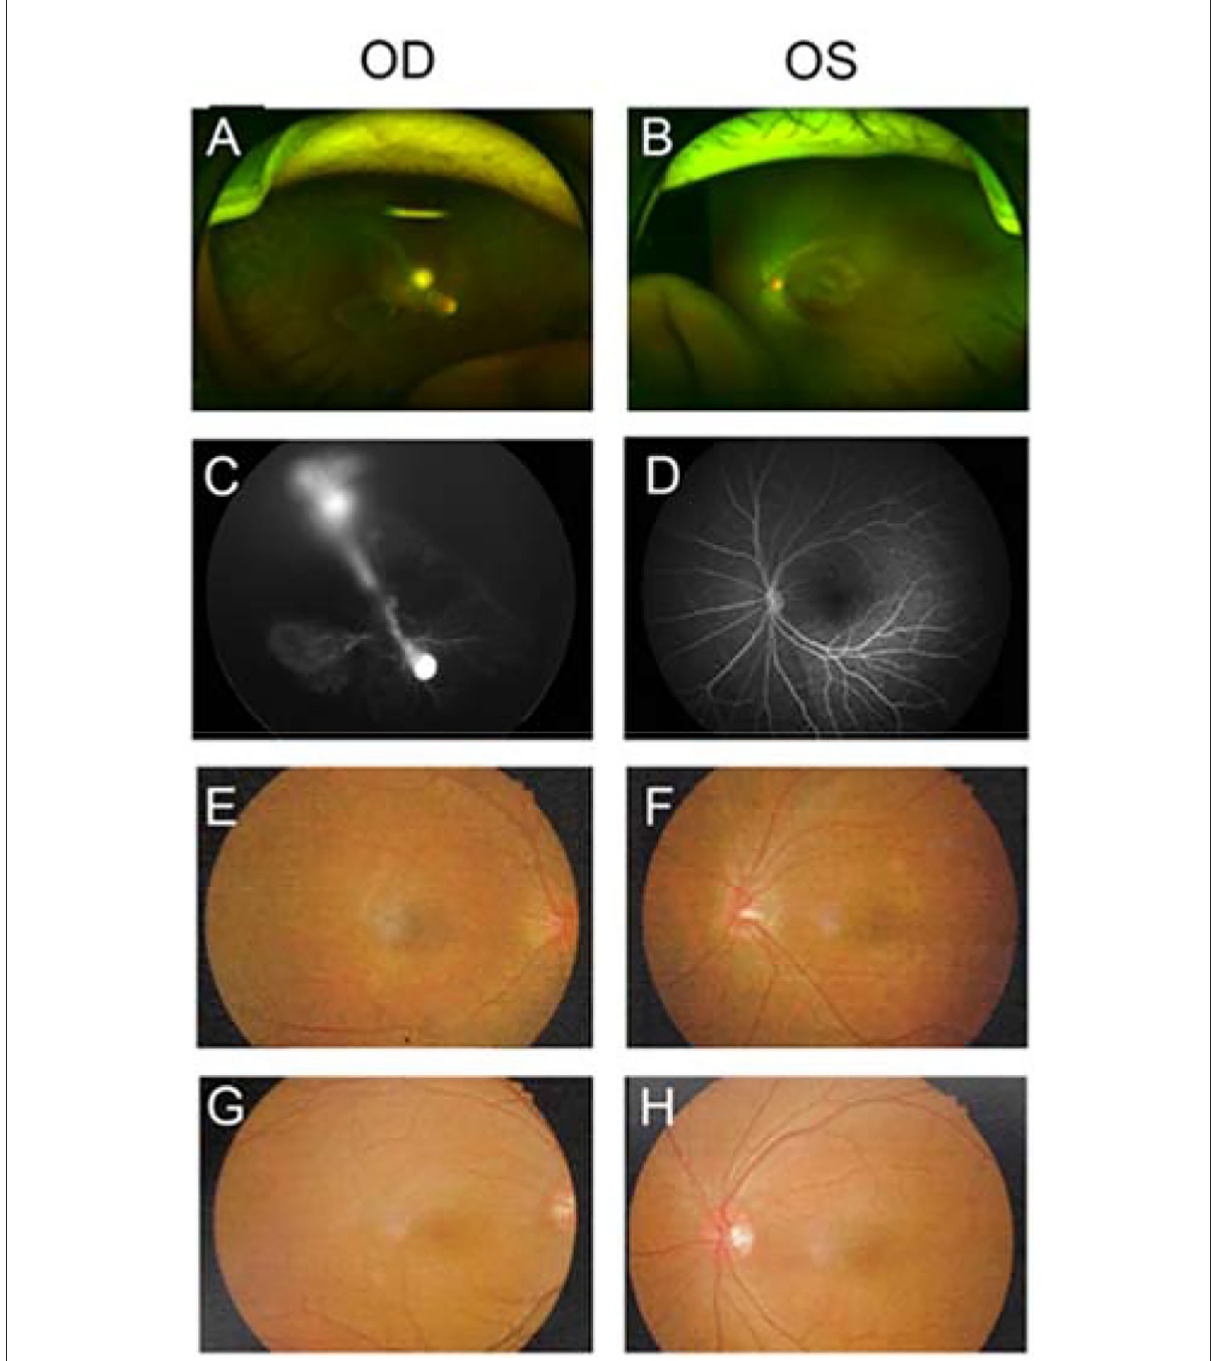
FIGURE1 Fundus photographs and fundus fluorescein angiography (FFA) of subjects from family No. 8. In this family, the c.205C > T mutation was detected in a 4-year-old proband boy and it was inherited from his father. OD and OS represented right eye and left eye, respectively. (A–D) Fundus and FFA photographs of FEVR proband. The proband suffered from monocular FEVR disease in the right eye and was staged 4A. Severe fibrous proliferation membrane connected the optic disc to the lens in the right eye, with subtotal retinal detachment and peripheral avascular zone. The left eye exhibited normal retinal appearance without prolonged filling time or leakage. (E,F) Fundus photographs of father. Fundus examination didn’t reveal any FEVR presentation although the father carried the c.205C > T mutation. (G,H) Fundus photographs of mother. The mother was a non-carrier without any fundus